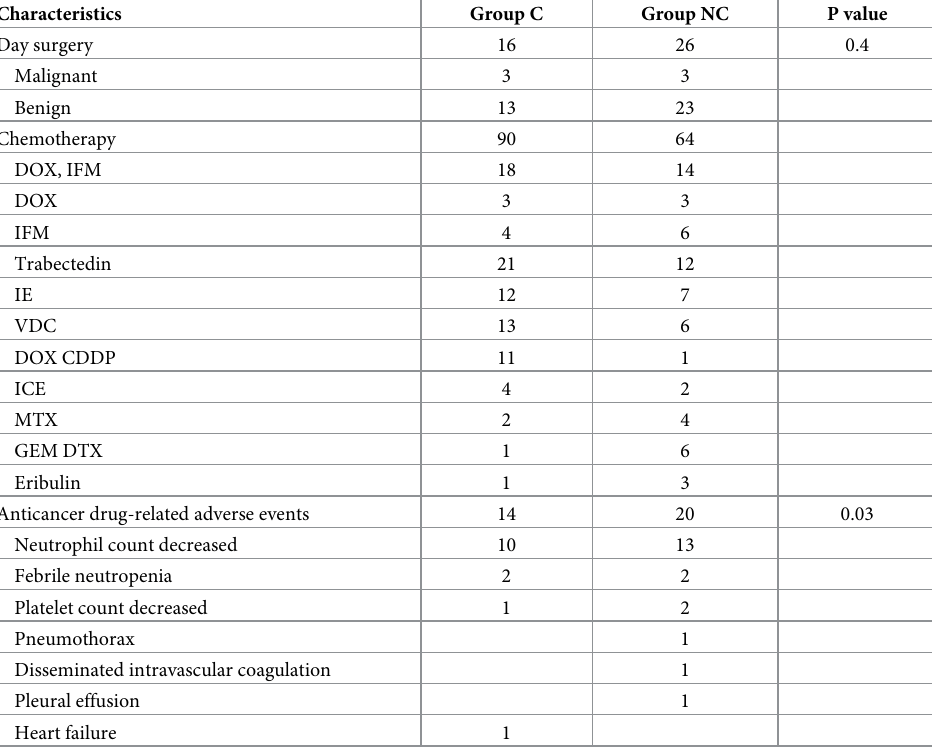
Table 2. Comparison of clinical information of corona era vs no corona era for day surgery and chemotherapy.